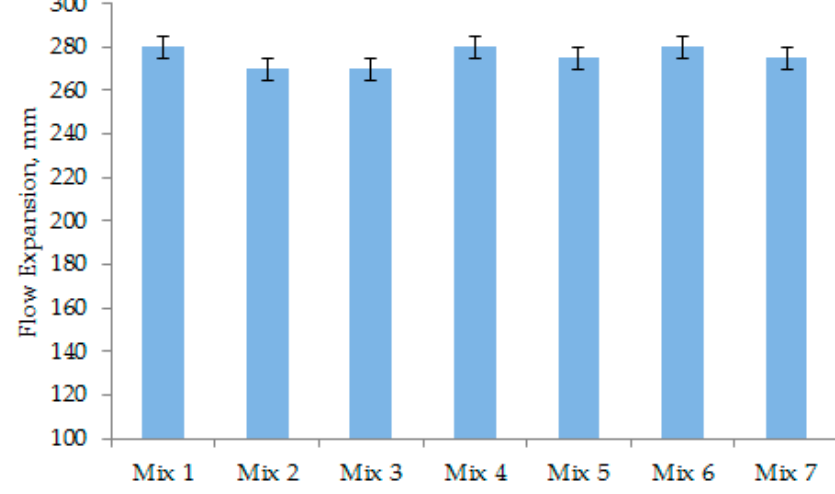
Figure 7. Flowability of the designated concrete mixes.